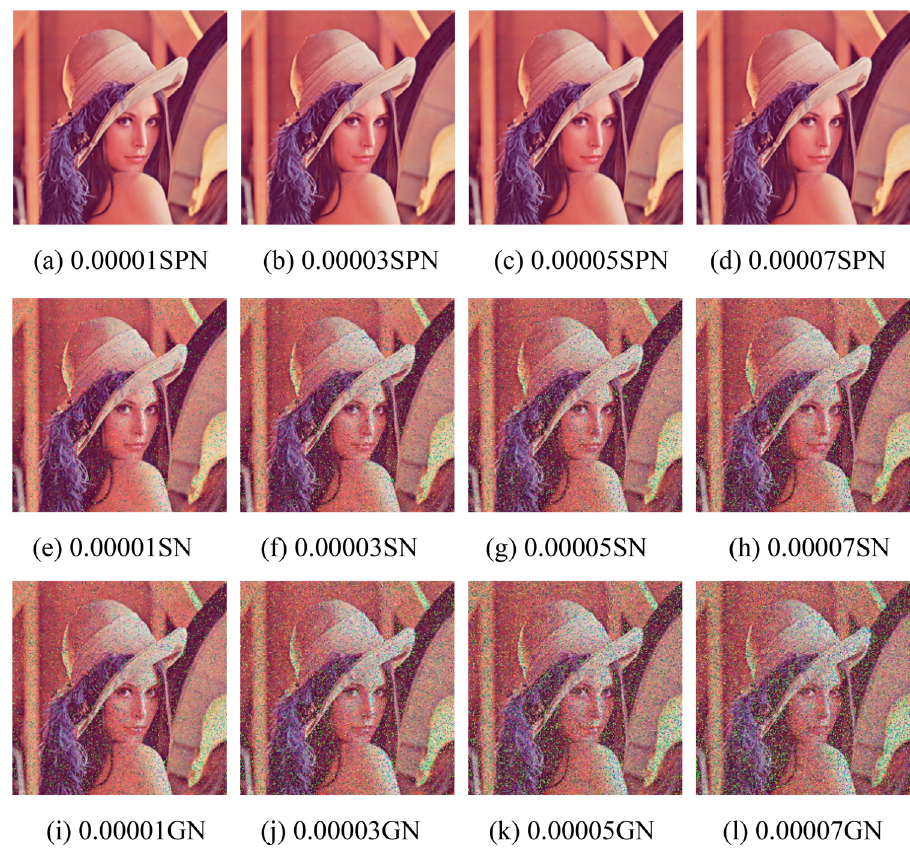
Fig. 12 The deciphered images with different noise